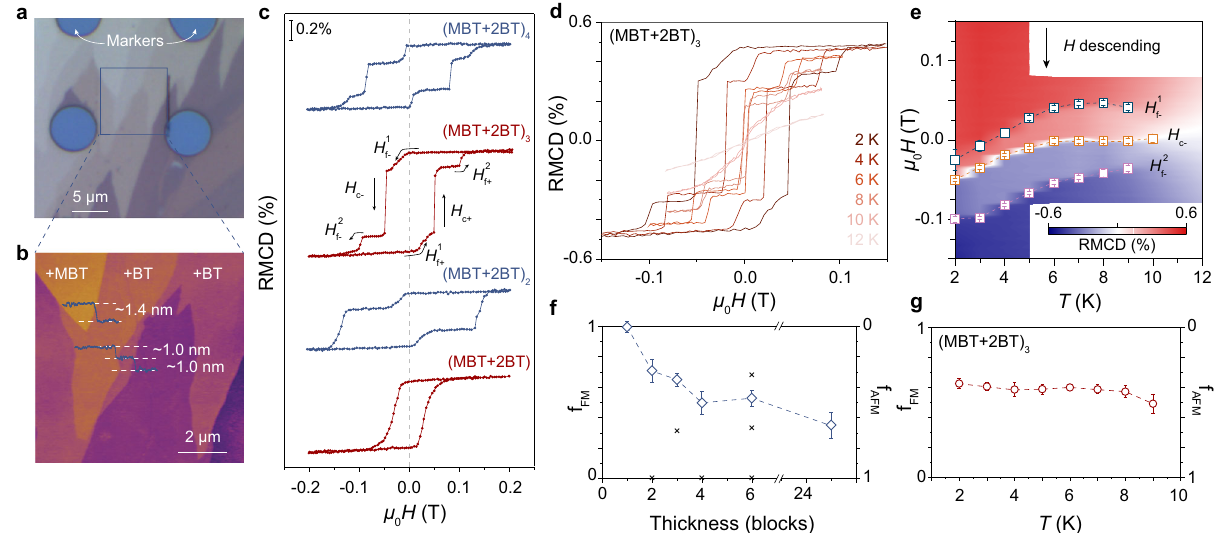
Fig. 1 | FM-AFM coexisting magnetic ground state in MnBi 6 Te 10 . a A typical optical image of the exfoliated MnBi 6 Te 10 sample with different thicknesses and terminations. b Atomic force microscopy height image and height line pro fi les measured in the area marked by the black box in ( a ), showing a thickness of ~1.4nm for MnBi 2 Te 4 SLand ~1.0nm for Bi 2 Te 3 QL. c RMCD signals versus μ 0 H for 1 to 4-SL (terminated by 2-QLprotection layer) MnBi 6 Te 10 fl akes at 2K. The subscripts “ + ” and “ − ” denote the fi eld-sweeping direction, and superscripts “ 1 ” and “ 2 ” denote the fi rst and second AFM transitions. d RMCD sweeps for the 3-SL MnBi 6 Te 10 fl ake at a temperature range that passes